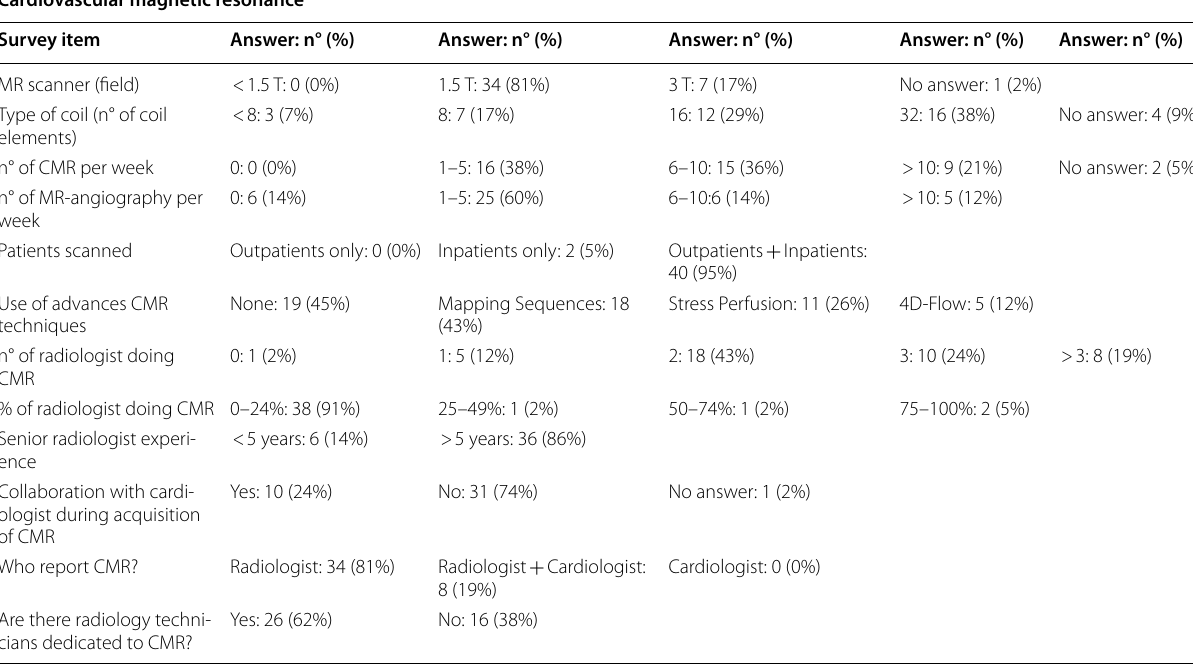
Table 2 Questions and answers on CMR diagnostic services